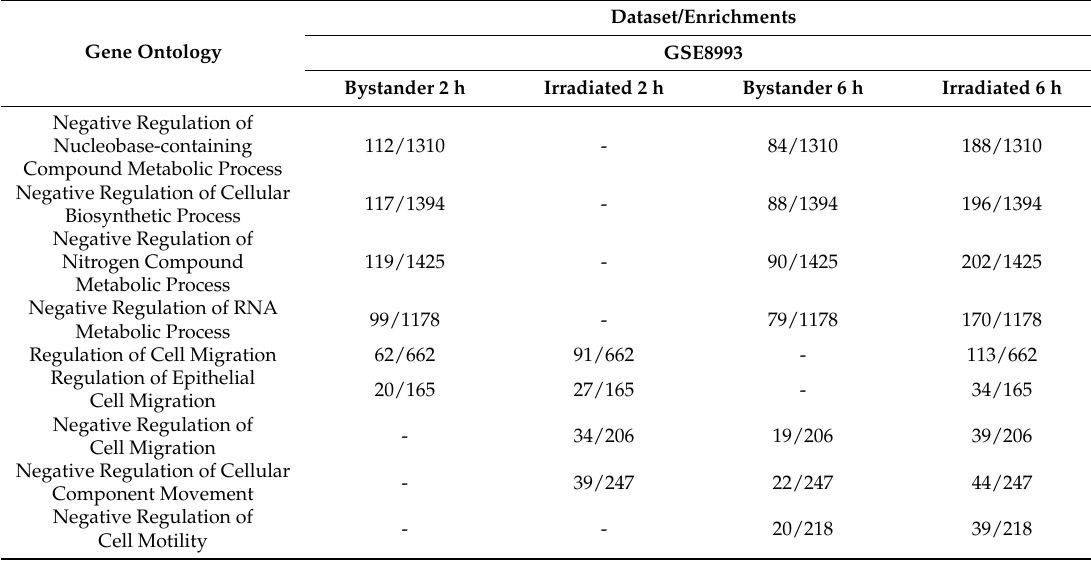
Table 4. Common Gene Ontology terms resulting from functional enrichment analysis for bystander vs. control and irradiated vs. control comparisons of dataset GSE8993 with carbon-ion irradiation. Enrichment scores are given as a fraction